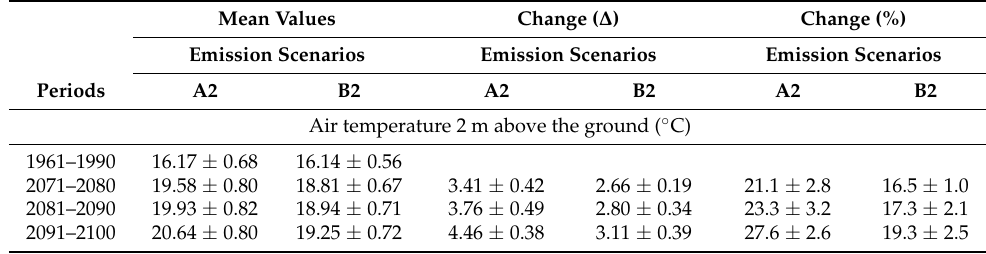
Table 1. Mean values of air temperature and relative humidity at 2 m from the surface, precipitation, incoming at the surface total short wavelength radiation and the cloud cover fraction for the time periods 1961–1990 *, 2071–2080, 2081–2090 and 2091–2100, as well as the changes in these parameters for the periods 2071–2080, 2081–2090 and 2091–2100 in relation to the reference period 1961–1990. The results are given as the mean and standard deviation of 13 simulations for the A2 emission scenario and 8 simulations for the B2 emission scenario, respectively, and are based on the Prudence program. A2 emission scenario: rapid increase in the atmospheric CO 2 concentration, which will reach 850 ppm by 2100. B2 emission scenario: increase in the atmospheric CO 2 concentration with moderate but steady rates, which will reach 620 ppm by 2100